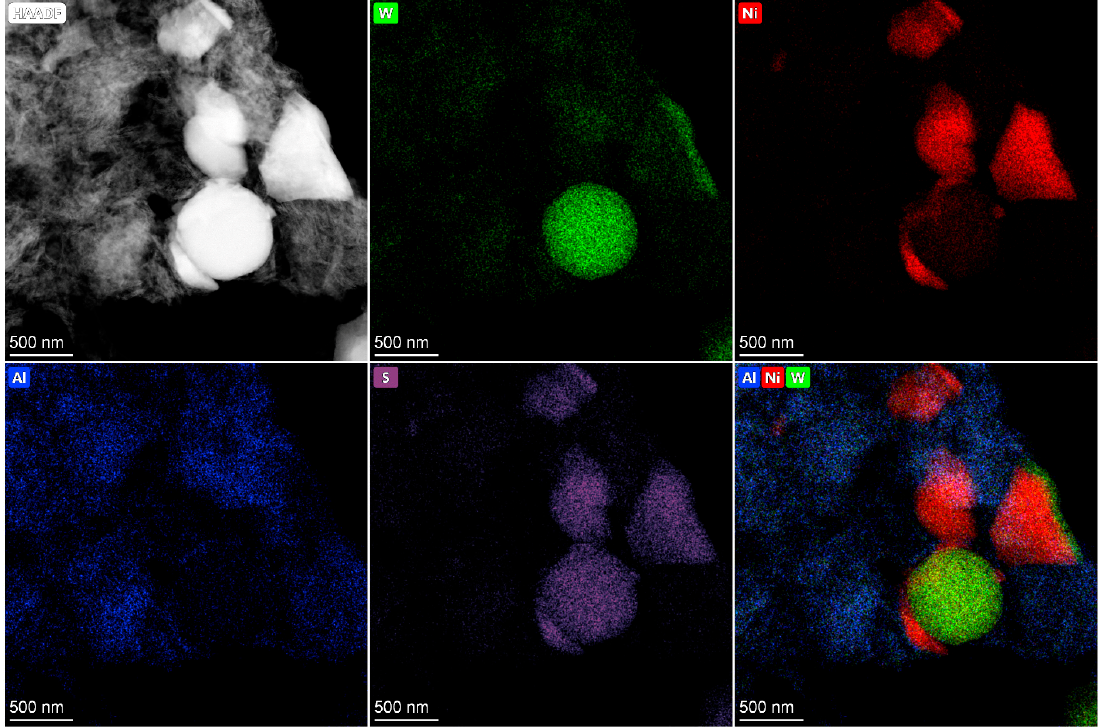
Figure 6. HAADF data on the c—Ni 1 W 1 sulfide catalyst after testing.